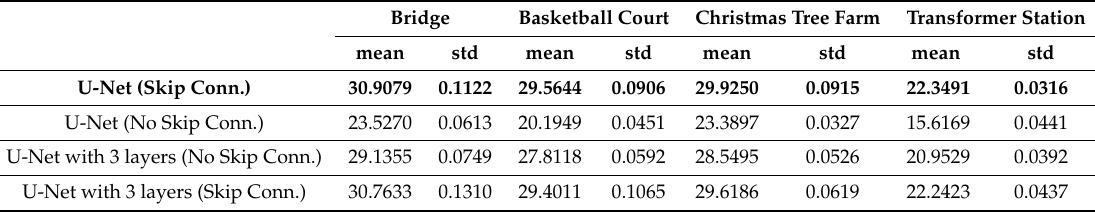
Table 3. Ablation study on skip connections: PSNR computed on test set.